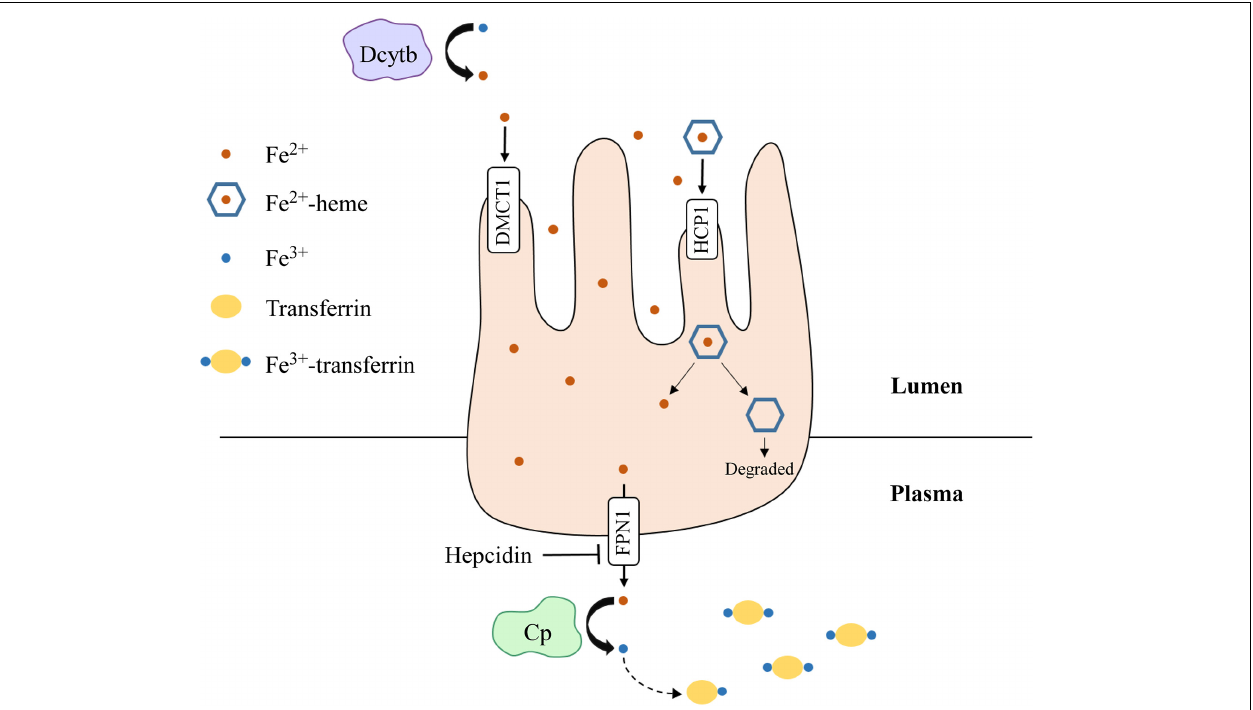
FIGURE 3 | Dietary iron absorption and transport from enterocytes to the plasma. Fe 3 + is reduced to Fe 2 + via duodenal cytochrome b (Dcytb) in the intestinal lumen. Non-heme-iron is transported into enterocytes via divalent metal cation transporter 1 (DMCT1), while heme-iron is transported through haem carrier protein 1 (HCP1). Heme dissociates from iron and is degraded. Fe 2 + is then exported out of enterocytes by ferroportin 1 (FPN1), whose function is inhibited by hepcidin. Once in the plasma, Fe 2 + is oxidized to Fe 3 + by ceruloplasmin (Cp), which then binds transferrin for transport through the plasma. Iron is transported into target cells for storage or